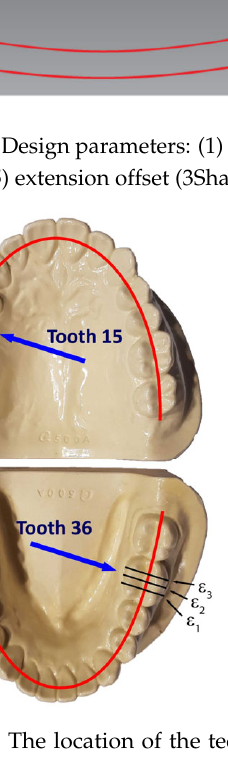
indication of the cross ‐ section planes for the analysis of shape